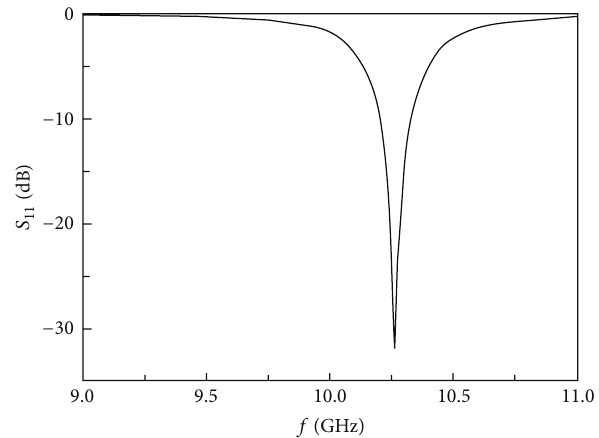
Figure 2: The simulated 𝑆 11 of the proposed MA from a normal incident planar wave.